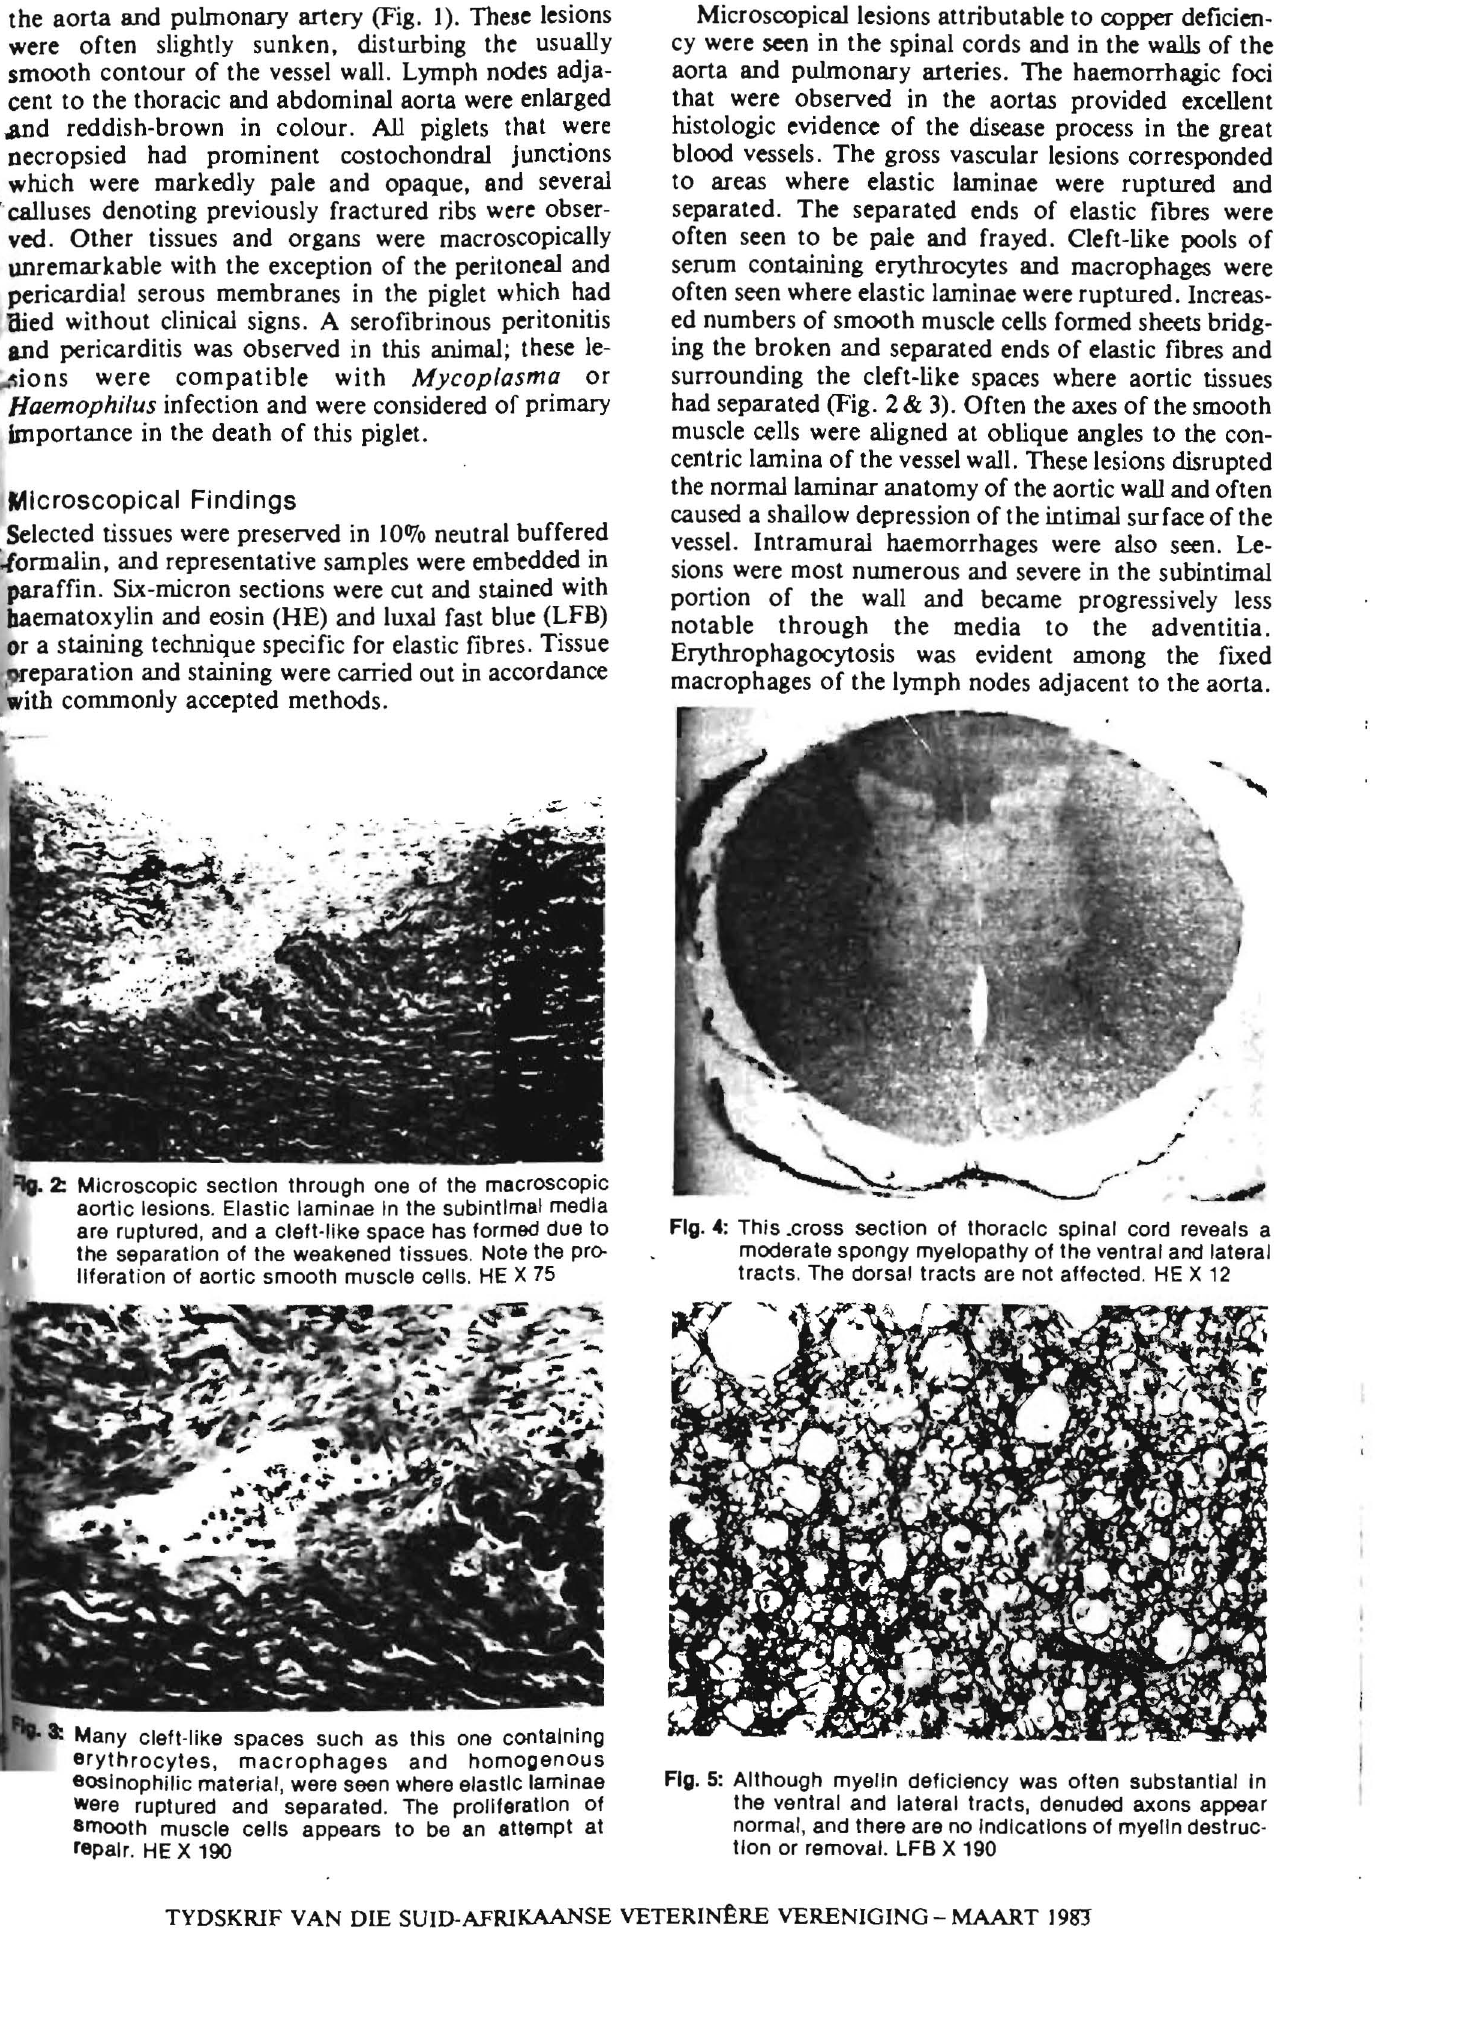
Fig. 5: Although myelin deficiency was often substantial In the ventral and lateral tracts, denuded axons appear normal, and there are no Indications of myelin destruc tion or removal. LFB X